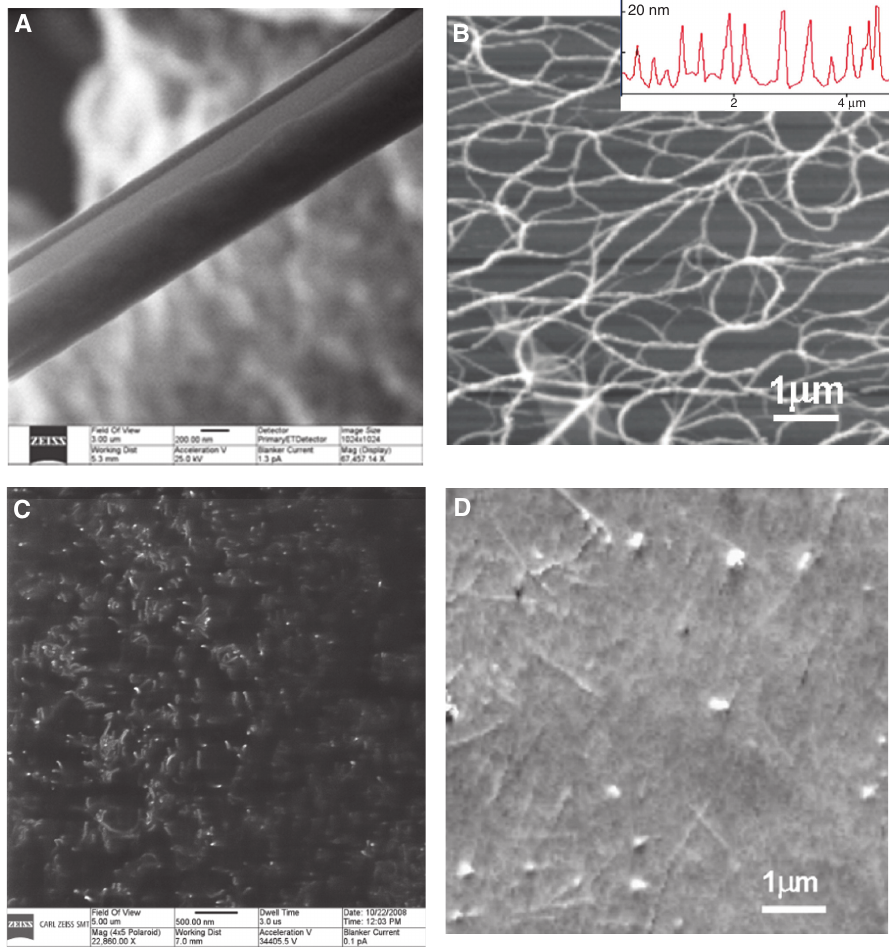
Figure 3 Comparison of SPM and HIM imaging of polymer-carbon nanotube